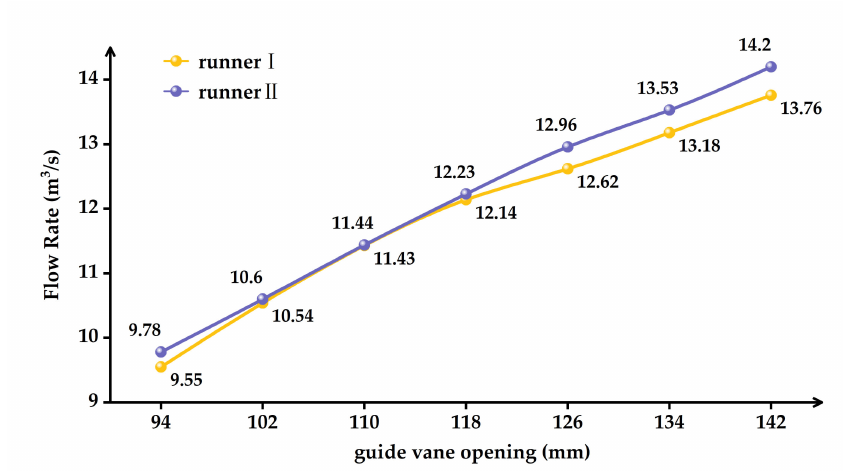
Figure 6. Relationship curve between flow rate and guide vane opening.